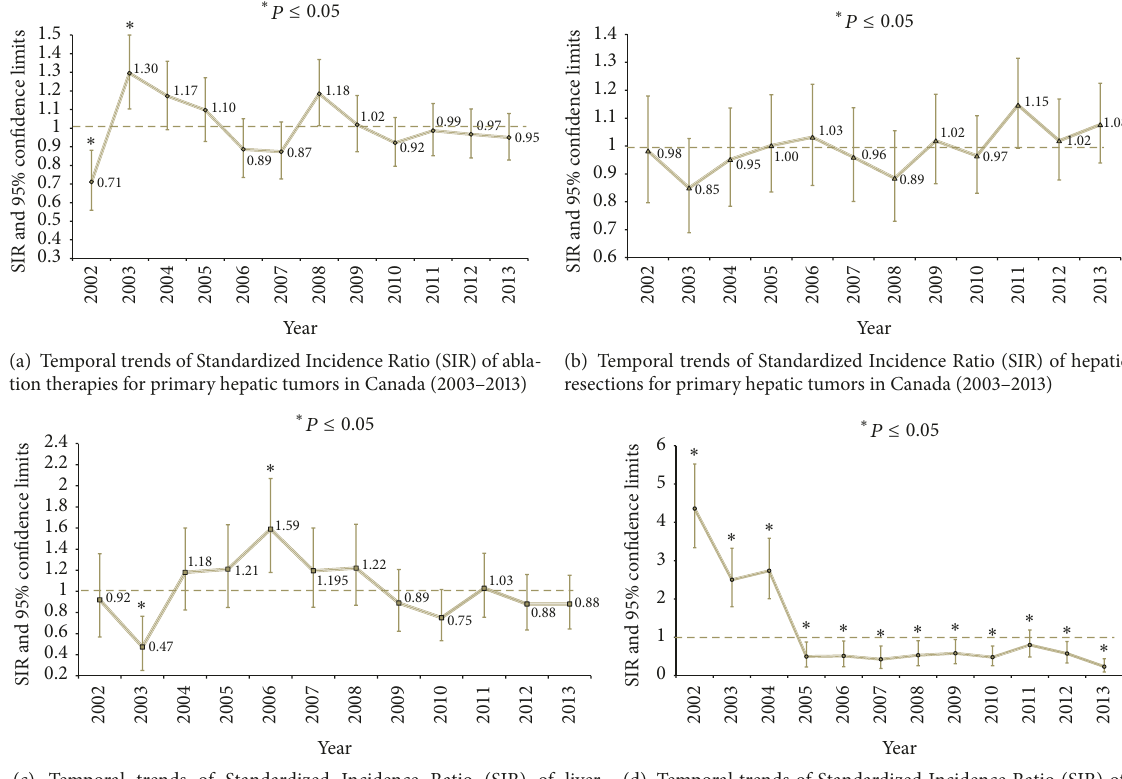
Figure2:TemporaltrendsoftheStandardizedIncidenceRatio(SRI)andrespective95%confidencelimitsfortreatmentmodalitiesofprimary hepatictumorsinCanadaovertheperiodbetween2002and2013.Overthestudyperiod,therewerenosignificanttemporalchangesinSIRsfor ablation, hepatic resection, or liver transplantation (a, b, c). On the other hand, transarterial locoregional therapies experienced a significant decline between the years 2004 and 2005 and national SIR remained below the expected value for all the following years (d). SRI values equal to 1.0 indicated that the treatment modality during the time period was equal to the expected countrywide average adjusted for population age and gender. SIR values more or less than 1.0 indicated that the treatment modality was above or below the expected countrywide average adjusted for age and gender. Statistically significant differences were identified when 95% confidence intervals of SIR did not include the value of 1.0 ( ∗ 𝑃 ≤